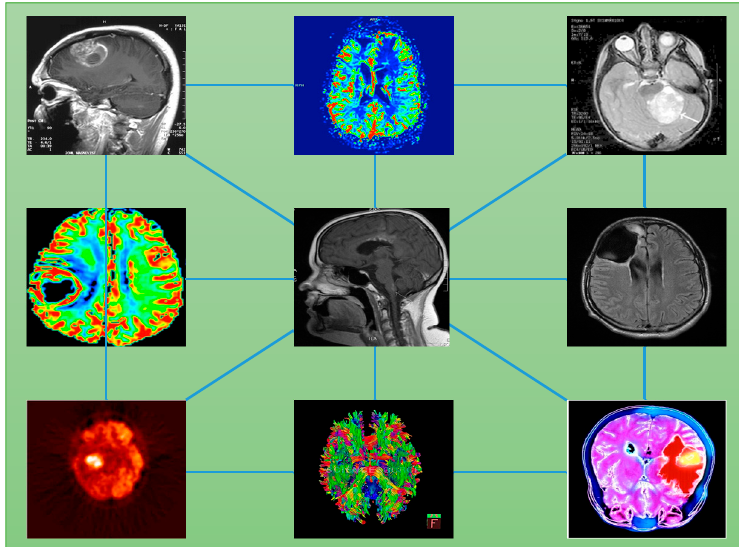
Figure 2. Image features integration from different imaging modalities.